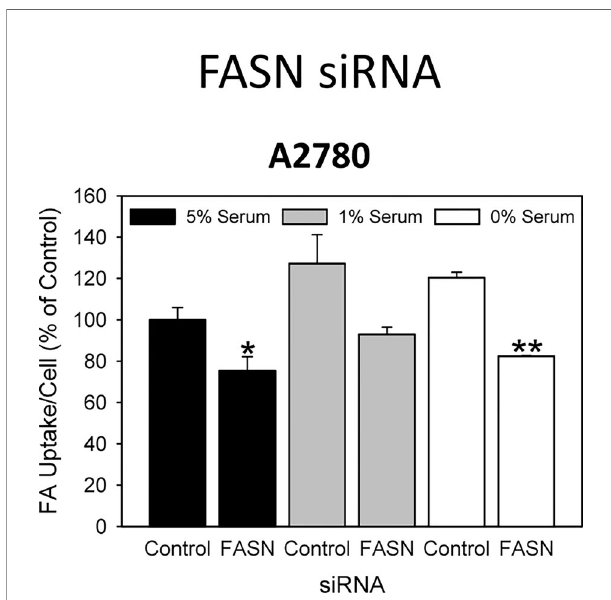
FIGURE 4 | A 48-hours knock-down of FASN by speci fi c siRNAs inhibits the uptake of exogenously supplied FA. Comparison of the data in the presence of 5%, 1% or 0% serum reveals that reduction of concurrent lipid contained in the serum can support the uptake of the fl uorescent dodecanoic FA analog BODIPY 500/512 C1, C12 in the untreated control cells, but cannot reverse drug-mediated reduction of FA uptake. Fluorescence signals were normalized to cell numbers that have been determined in parallel by formazan dye cell proliferation assays and were expressed in % of vehicle(0.1% DMSO)-treated control cells grown in the presence of 5% serum. Means ± SD, n = 3. One- tailed Student ’ s t-test at p < 0.05 (*) and p < 0.01 (**) between cells transfected with FASN-targeting siRNA (FASN) or with non-targeting control siRNA (Control) grown in the presence of the corresponding concentration (5%, 1% or 0%) of